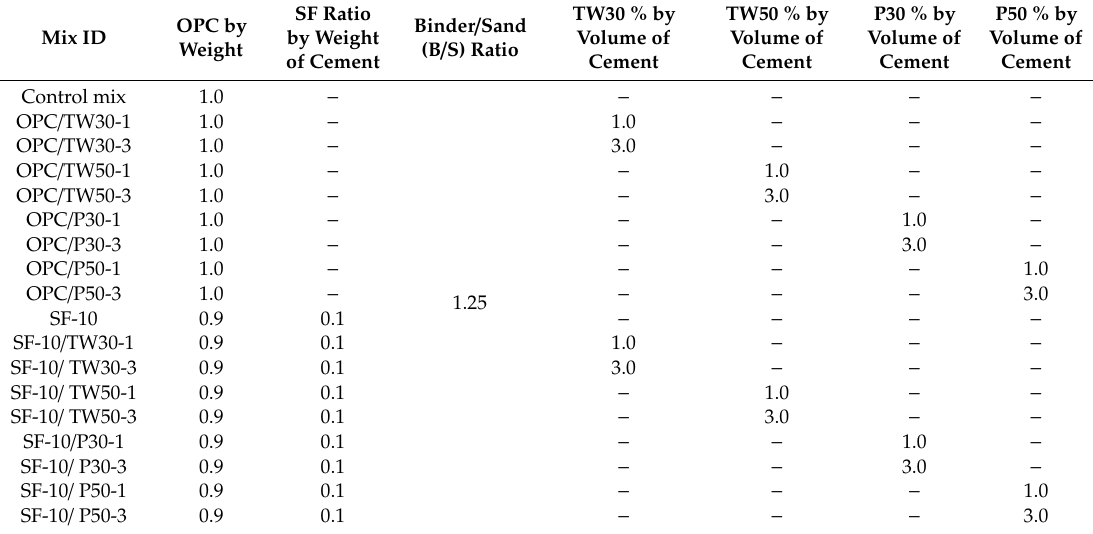
Table 4. Detailed mix